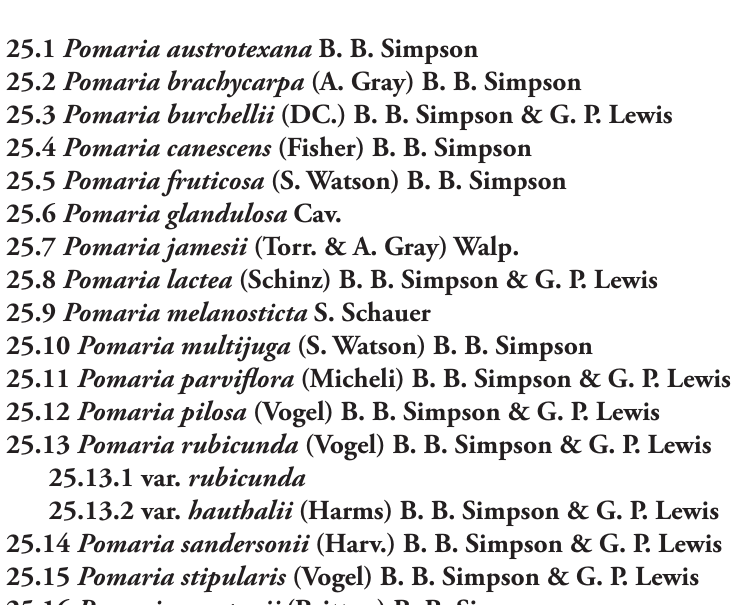
Figure 39. Continued. F flower G habit H fruits (O. Bourquin, Flora of Zimbabwe (http://www.zim- babweflora.co.zw/), Ghanzi district, Botswana, unvouchered ). Arquita grandiflora E. Gagnon, G. P.